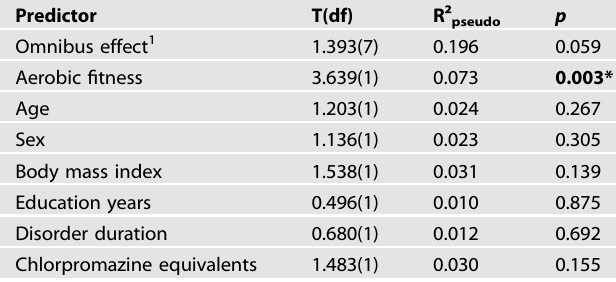
Table. 2. Seeds of interest from the Brainnetome Atlas. Names of seeds from Brainnetome Atlas